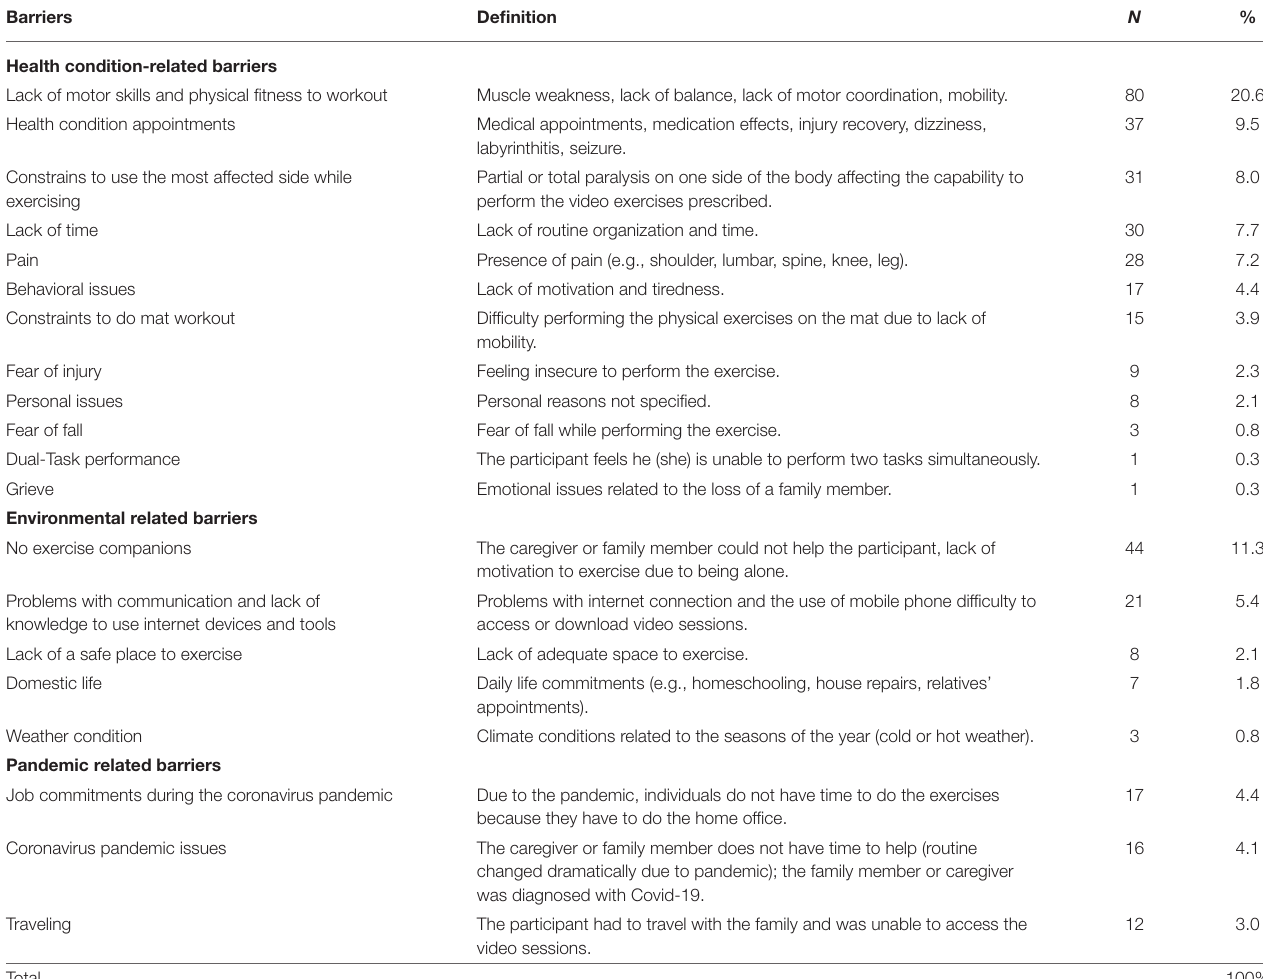
TABLE 4 | Absolute and relative frequency of reported